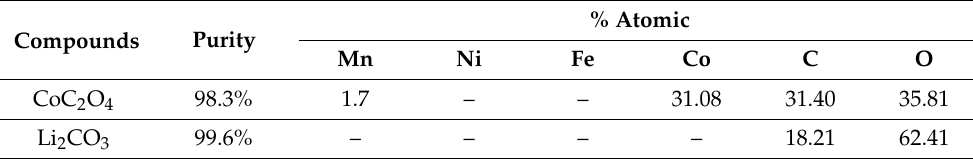
Table 3. EPMA results of analysis of the synthesized solids, as shown in Figure 6b,d.